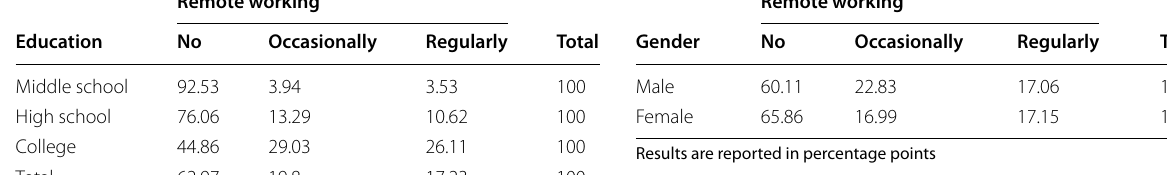
Estimates from regression (1) of STW (column 1), work last week (column 2), relative hours worked last week (column 3) and family leave (column 4) on a constant, female dummy and COVID-19 stringency index. The sample is restricted to respondents who are employed or apprentices. Regressions estimated with linear probability model, including random effects. Standard errors in parentheses